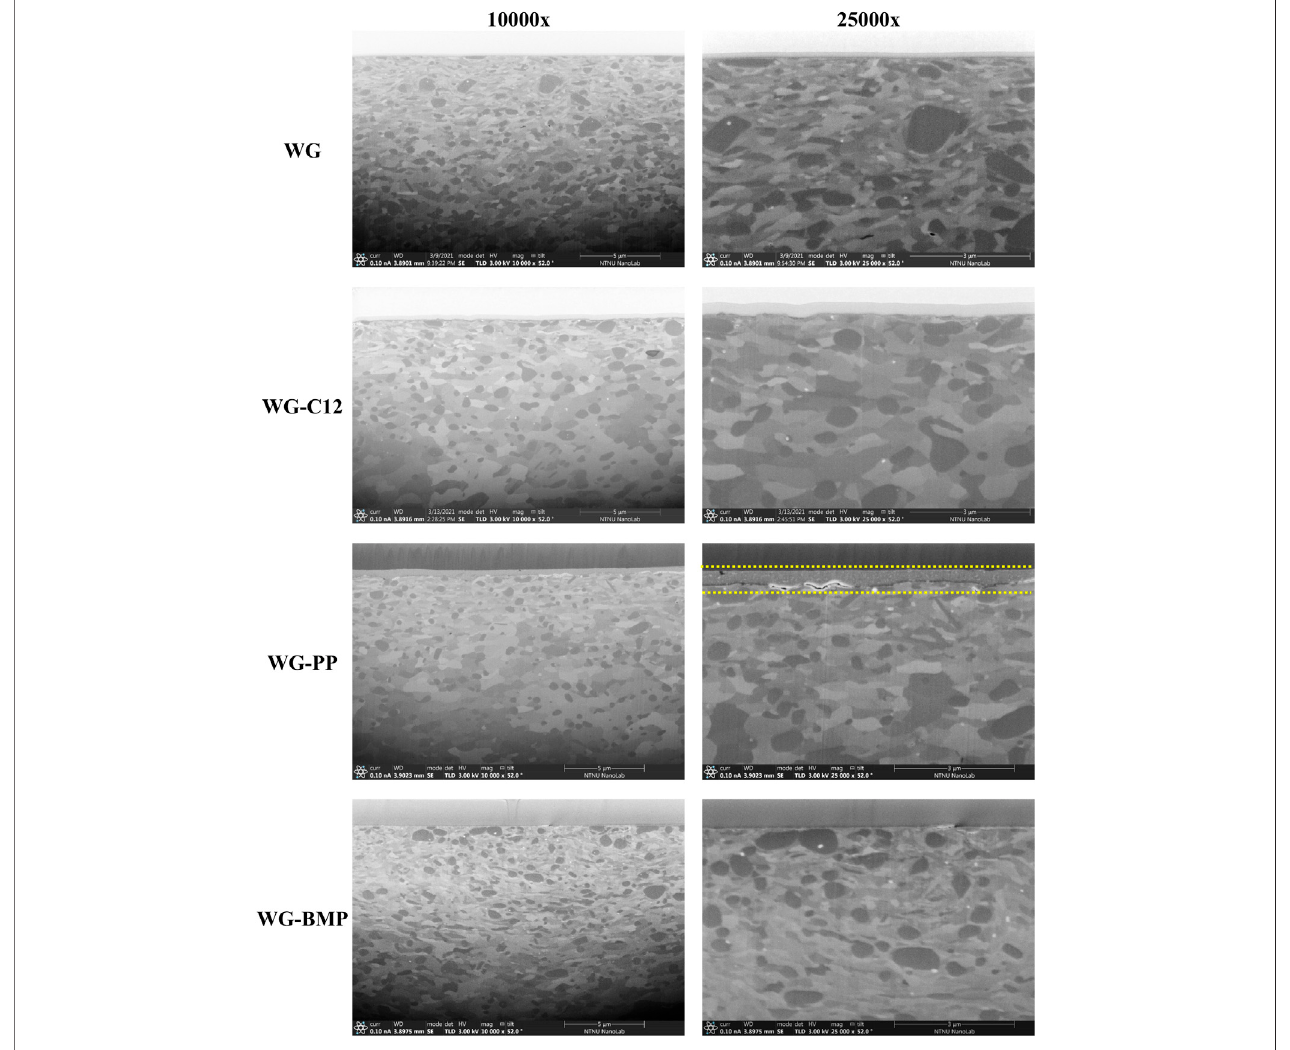
FIGURE 3 | SEM-FIB cross-section images of the wear tracks on AISI 52100 steel disk tested in different lubricants at room temperature (tribo fi lm is indicated between two dashed yellow lines).